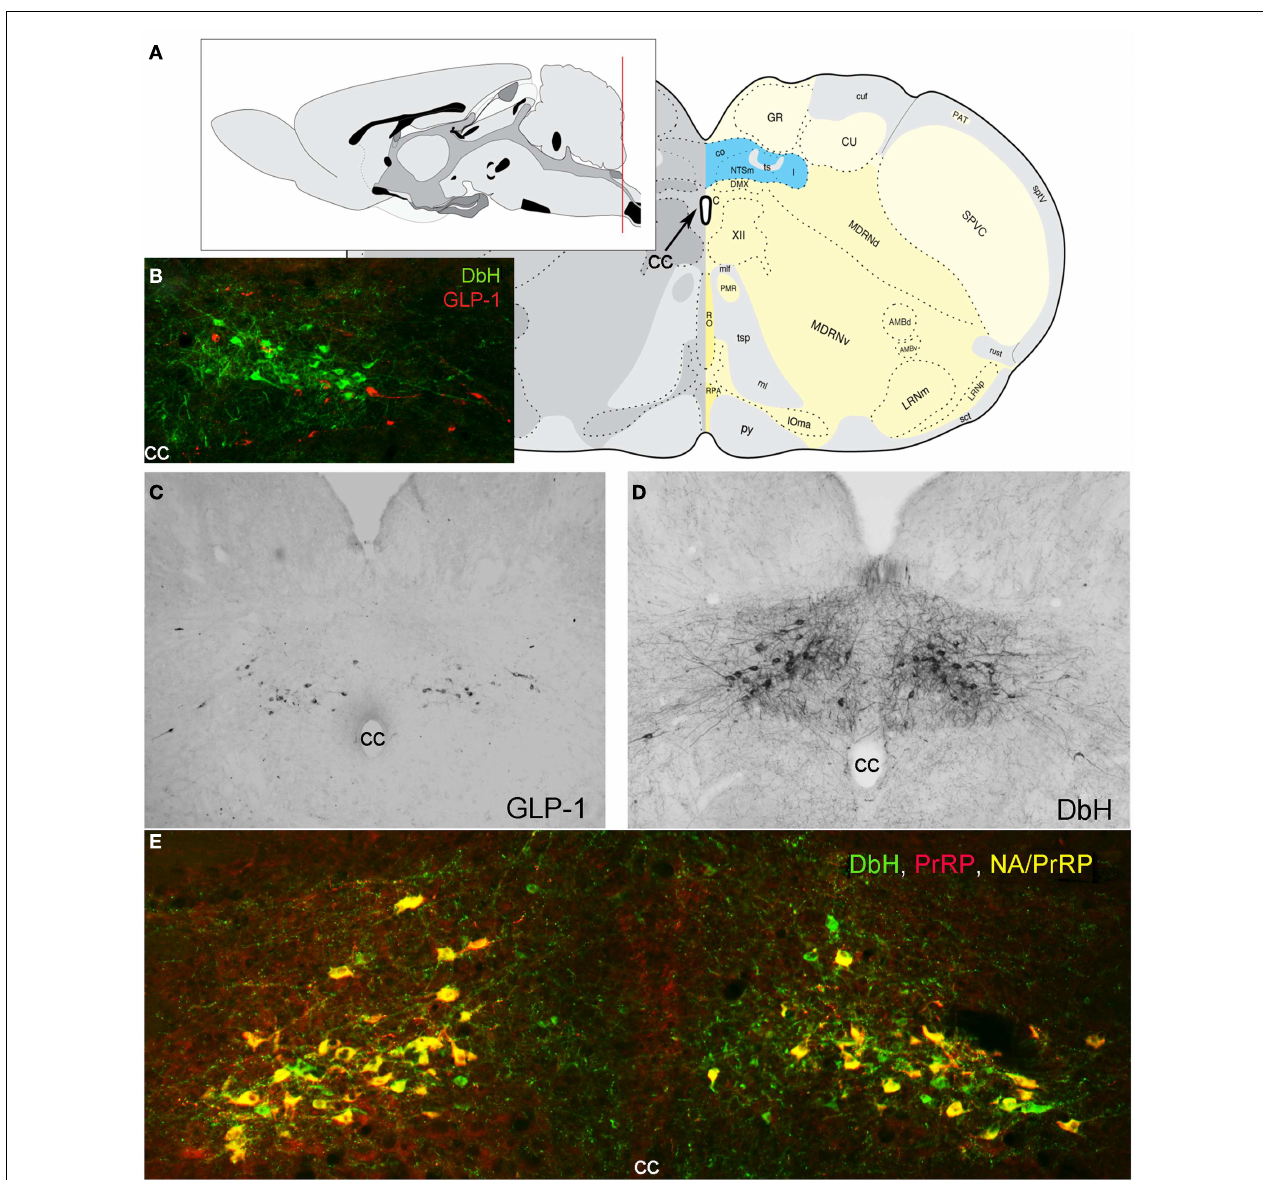
are red.The two intermingled populations are distinct, with no colocalization of immunolabeling. (C) GLP-1 immunoperoxidase-labeled neurons. (D) DbH immunoperoxidase-positive NA neurons of the A2 cell group. (E) In this image, all PrRP-positive neurons are double-labeled for DbH, rendering them yellow/orange (NA/PrRP neurons). Some intermingled NA neurons (green) are PrRP-negative, cc, central